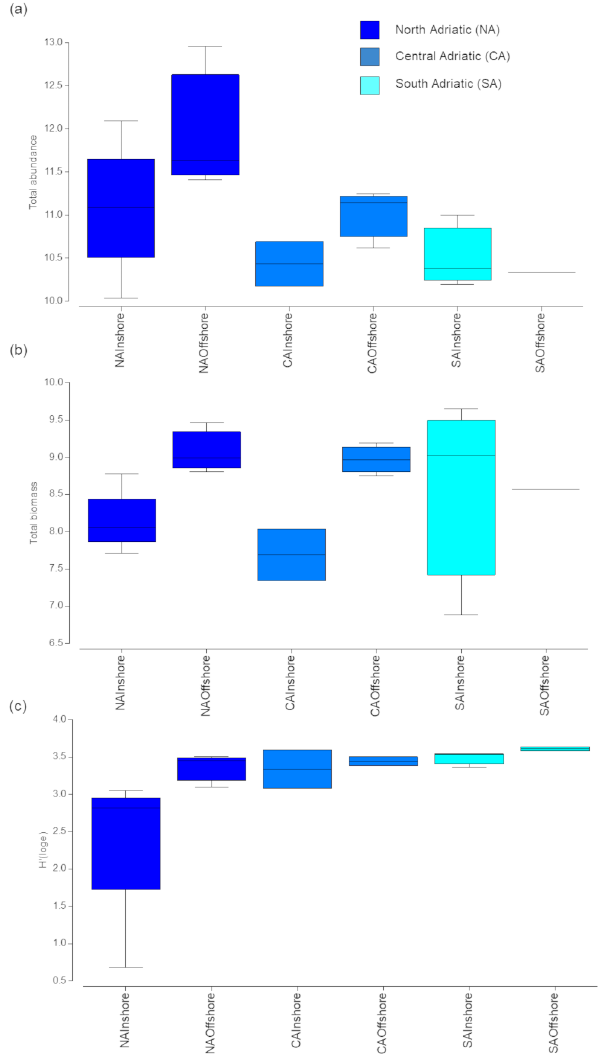
Figure 2. Total abundance (number of individuals per square me- tre, a ), total biomass (mg WWm − 2 , b ), and diversity ( H (cid:48) , c ) of mesozooplankton at each group of stations by sub-area and distance from the coast (inshore vs. offshore stations). Colours define the different sub-areas. Boxes are interquartile ranges; black lines that divide the box into two parts represent the medians; and the upper and lower whiskers represent scores outside the middle 50%.